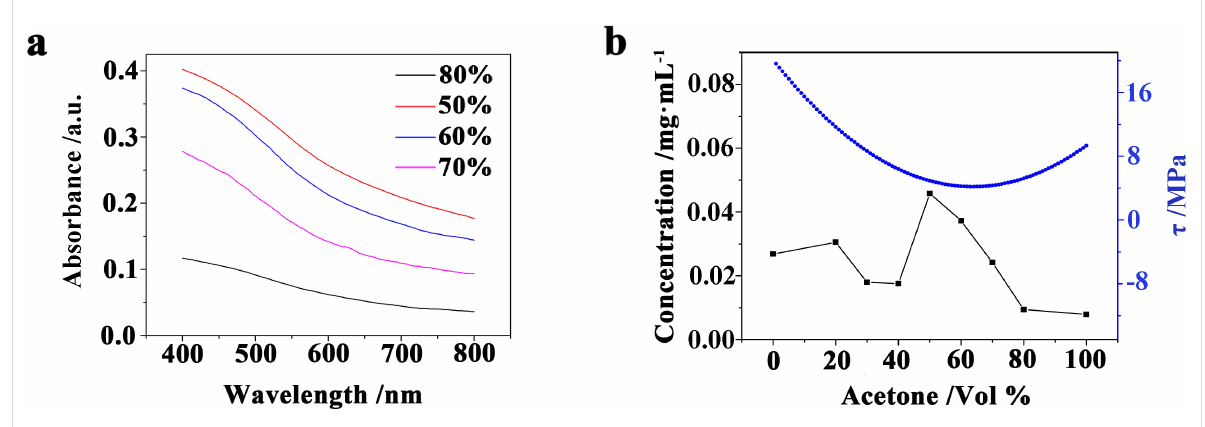
Figure 6: Results of KP 15 dispersions exfoliated in acetone/water mixtures. (a) Absorbance of KP 15 dispersions exfoliated in acetone/water mixtures with different acetone volume fractions. (b) KP 15 suspension concentration and the calculated τ as a function of the acetone volume fraction.